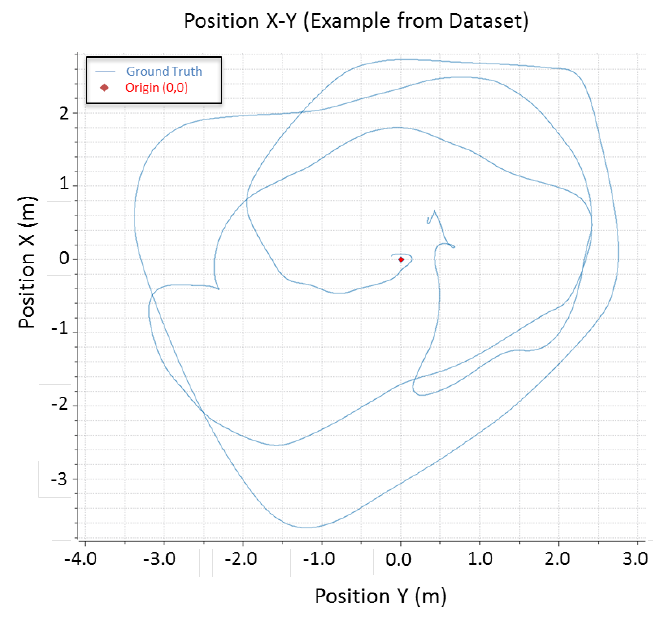
Figure 6. Sample trajectory from one of the published flights.